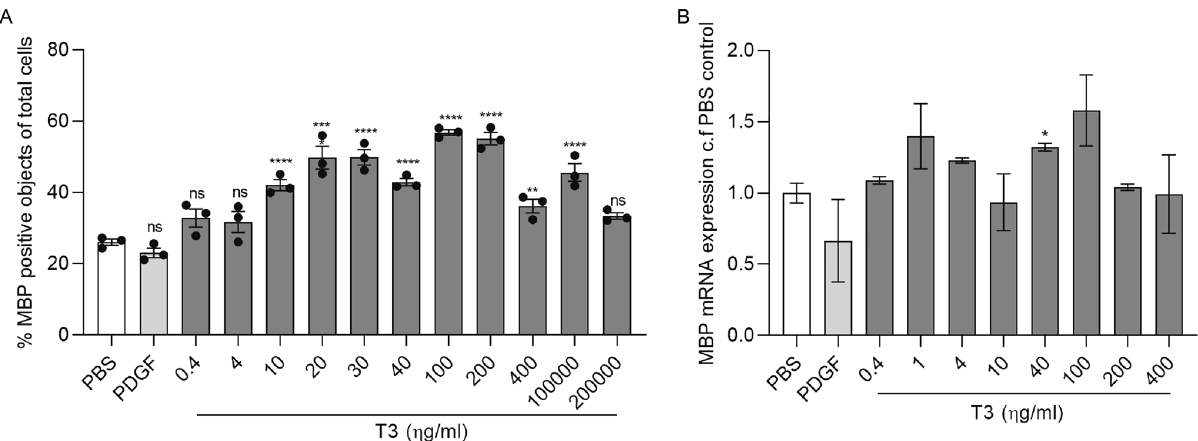
Figure 2. T3 promotes OPC into OL differentiation. ( A ) Differentiated OLs quantified from MBP + stained cells normalized to total cell number. Four day treatments of O4 + OPCs with increasing concentrations of T3 (0.4– 200,000 ng/ml), n = 3 are compared to PBS control and PDGF negative control. ( B ) Fold change MBP mRNA expression of differentiated OLs with increasing concentrations of T3 (0.4–400 ng/ml), n = 2 are compared to PBS control and PDGF negative control. Individual values show mean ± SEM, analysis was done by an unpaired t-test with 95% confidence interval, ns not significant, *P < 0.05, **P < 0.01, ***P < 0.001, ****P <